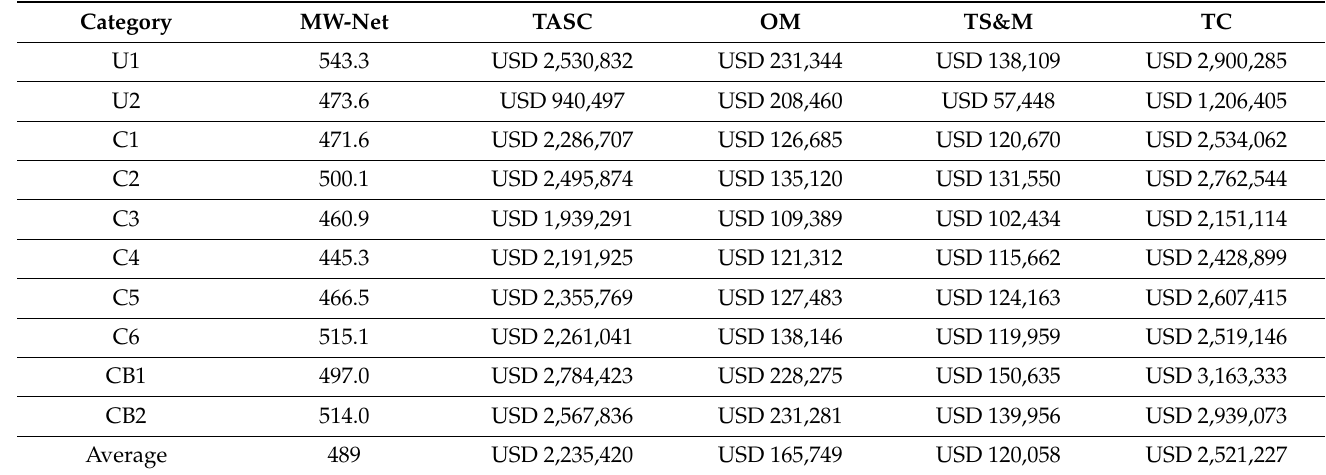
Table 3. Total cost of the selected CSMs for the power station. Source: NETL [39–41].